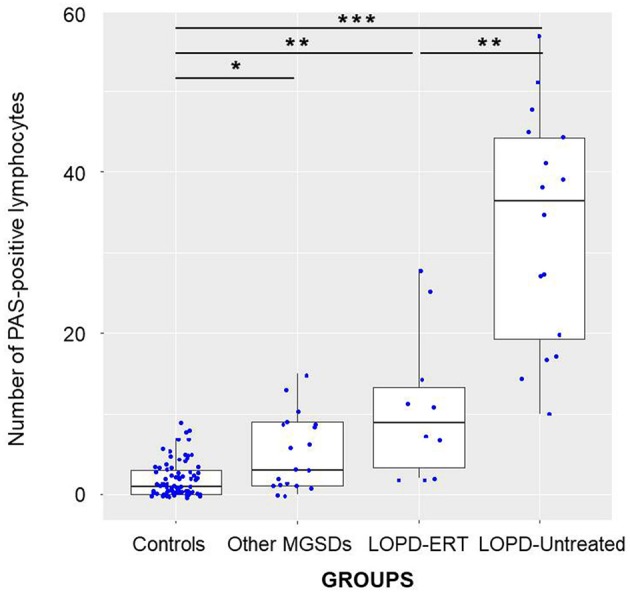
A comparison of the number of vacuolated lymphocytes in patients with LOPD dichotomized into untreated and ERT-treated vs. controls and other MGSD. The black horizontal line in each box represents the median, with the boxes representing the interquartile range. Significant differences are indicated with *p < 0.05, **p < 0.01, or ***p < 0.001.